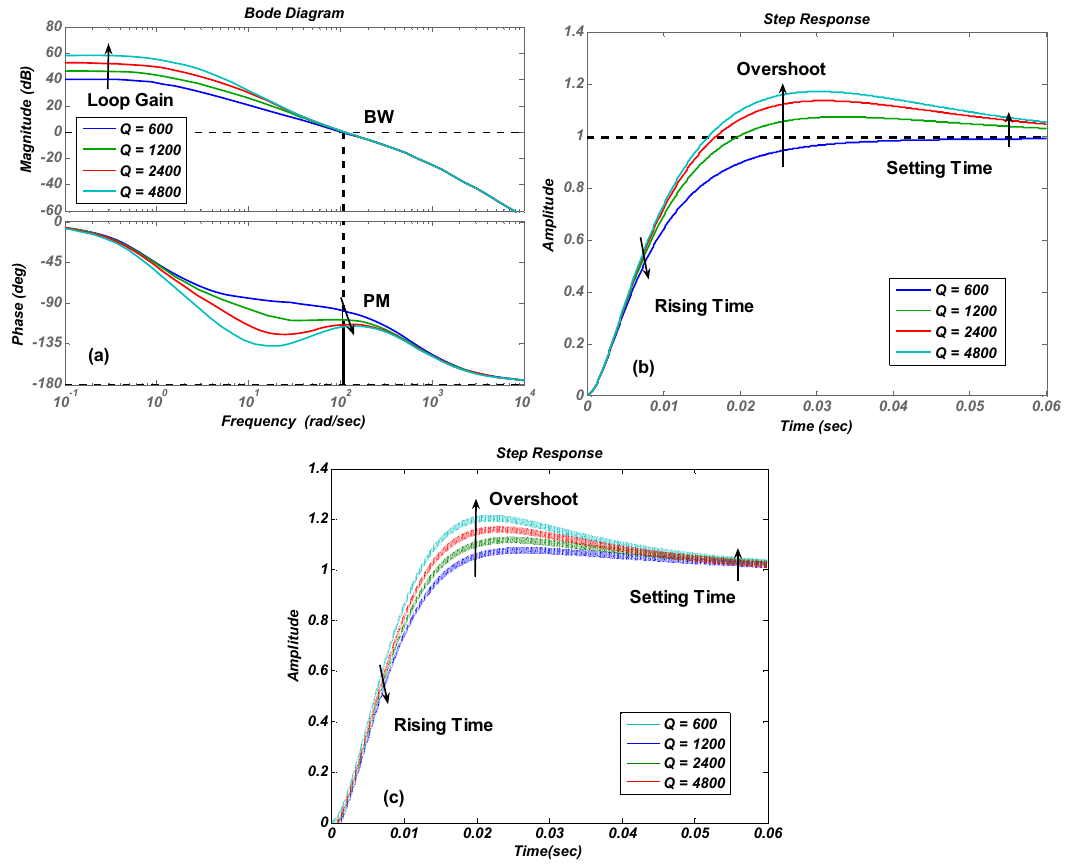
Figure 7. ( a ) Bode diagrams of the control loop ( b ) step responses of the linear model ( c ) and step responses of nonlinear model varying with the quality factor Q .